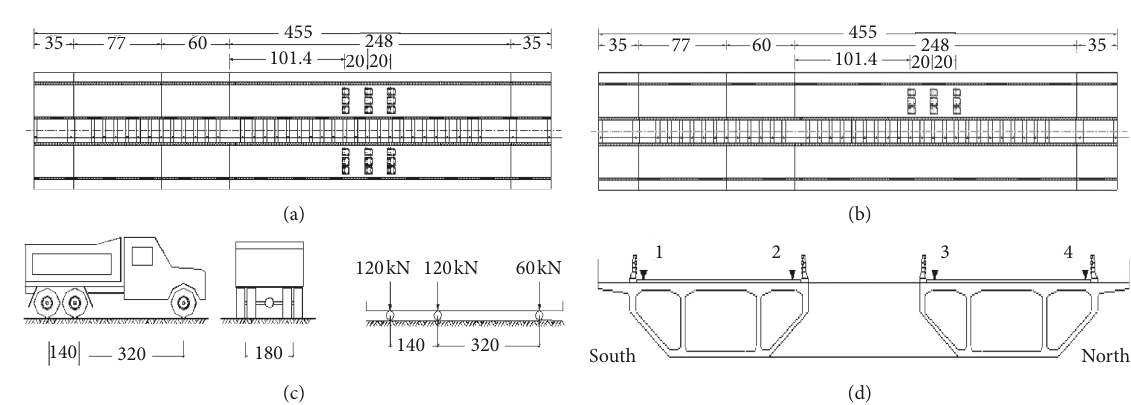
Figure 4: Cases of the static test. (a) Symmetric loading. (b) Partial loading. (c) Truck model. (d) Layout plan of